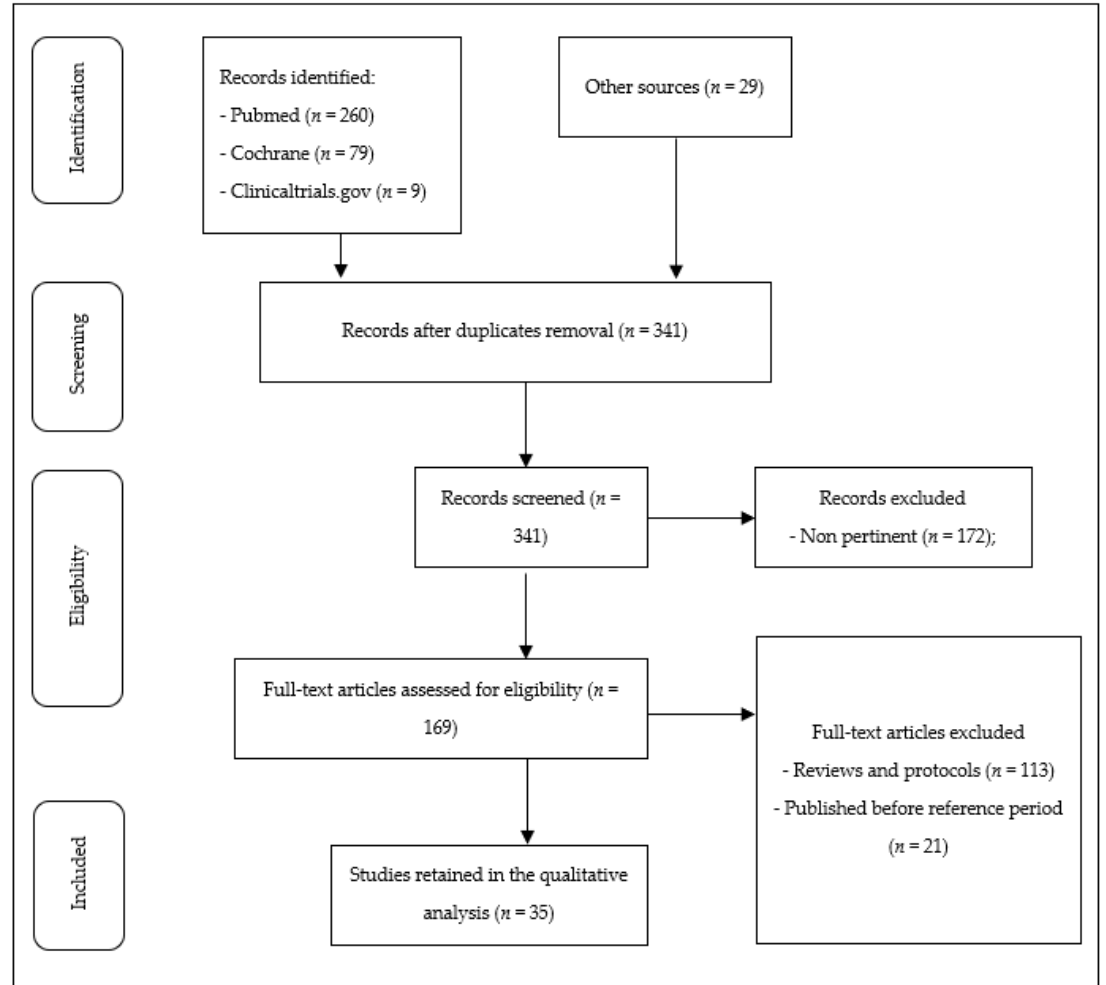
Figure 2. Flowchart of the study.